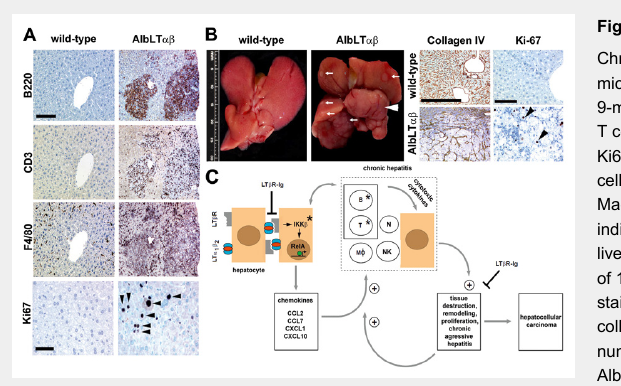
Chronic inflammation-induced liver damage and HCC in AlbLTαβ mice. (A) Immunohistochemistry of representative livers from 9-months-old C57BL/6 and AlbLTαβ mice. B220 + B cells, CD3 + T cells, F4/80 + macrophages, Kupffer cells (scale bar: 150 μm). Ki67 + , proliferating hepatocytes (arrowheads) or inflammatory cells are indicated (scale bar: 50 μm). (B, left two panels) Macroscopy of C57BL/6 and AlbLTαβ livers. White arrows indicate tumour nodules. White arrowhead indicates a complete liver lobe affected by HCC. (B, right four panels) Liver histology of 12-month-old C57BL/6 and AlbLTαβ mice. Collagen IV staining highlights the broadening of the liver cell cords, loss of collagen IV networks indicate HCC (scale bar: 200 μm). High numbers of Ki67 + proliferating hepatocytes (arrowheads) in AlbLTαβ HCC (scale bar: 100 μm). (C) Scheme of chronic inflammation-induced liver carcinogenesis in AlbLTαβ